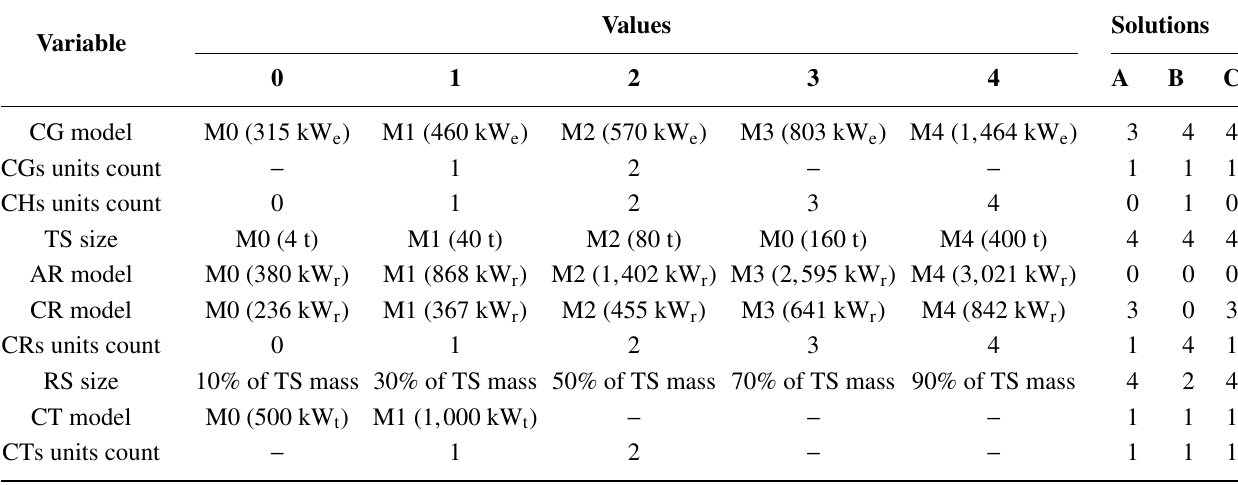
Table 3. Synthesis and design decision variables and characteristic solution values.